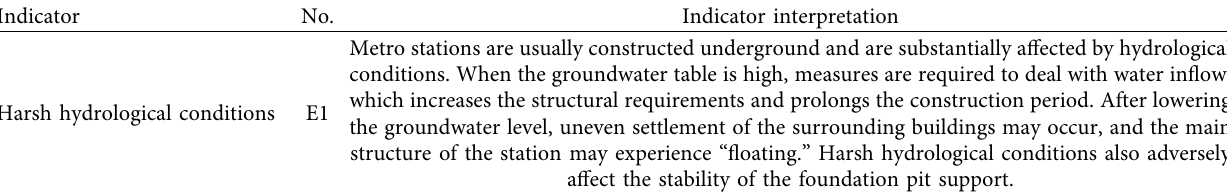
Table 3: Index system and interpretation of environmental risk assessment for metro